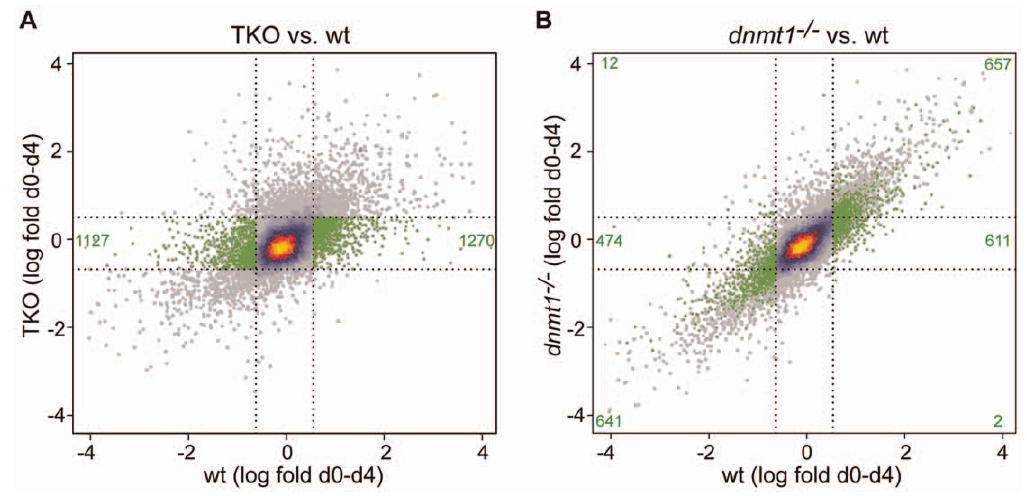
Figure 4. Genome-wide expression changes in early wt, Dnmt1 2 / 2 and TKO EBs. Scatter plots of genome-wide expression changes between day 0 and 4 in TKO (A) and Dnmt1 2 / 2 EBs (B) relative to wt EBs. Data points are heat-colored according to their local density. About 17% of 25528 analyzed genes changed expression level in wt EBs according to the thresholds indicated by the vertical dotted lines. Genes whose expression levels increased and decreased in wt but not in TKO EBs (‘‘TKO non-responders’’, parts of the corridor between the horizontal dotted lines to the left and right of the vertical dotted lines in A) are marked in green in both A and B and their numbers are reported in green in the respective sectors.